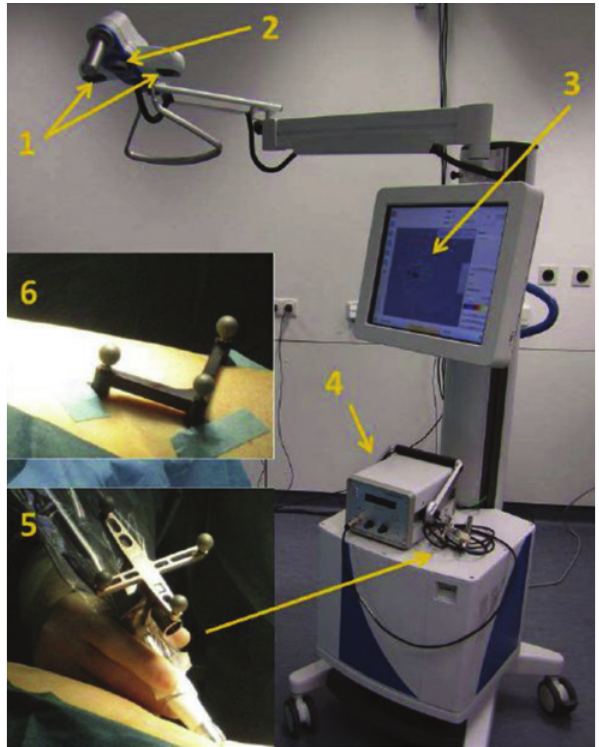
Figure 8: Surgical setup of a freehand SPECT system by Declipse (Surgieye, Munich,